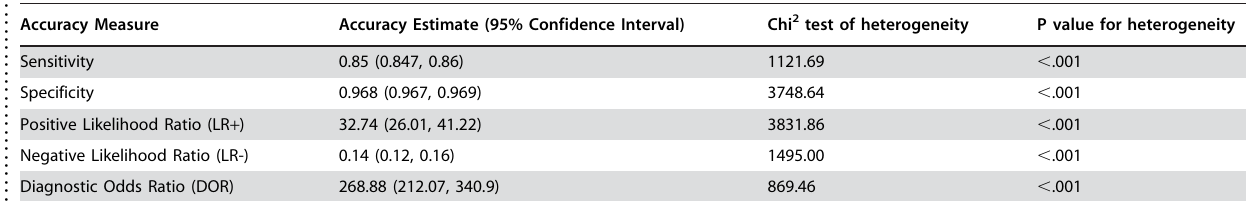
Table 3. Pooled Summary Estimates of 125 Commercial NAAT Studies (adding 0.5 to all cells of studies with 0 values) .. ... .... ... ... .... ... ... .... ... ... .... ... ... .... ... ... .... ... ... .... ... ... .... ... ... .... ... ... .... ... ... .... ... ... .... ... ... .... ... ... .... ... ... . Accuracy Measure